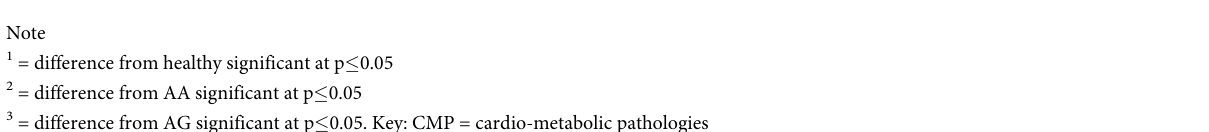
type homozygotes (Table 3). Country-specific analysis showed that in the healthy Greek popu- lation, heterozygous individuals of A-112C and Ala64Thr displayed higher BMI and fat mass compared to the wild type homozygotes (BMI p = 0.005, body fat p = 0.008 and BMI p = 0.002, body fat p = 0.005, respectively; S14 Table in S1 File). In the Polish healthy population, mutant